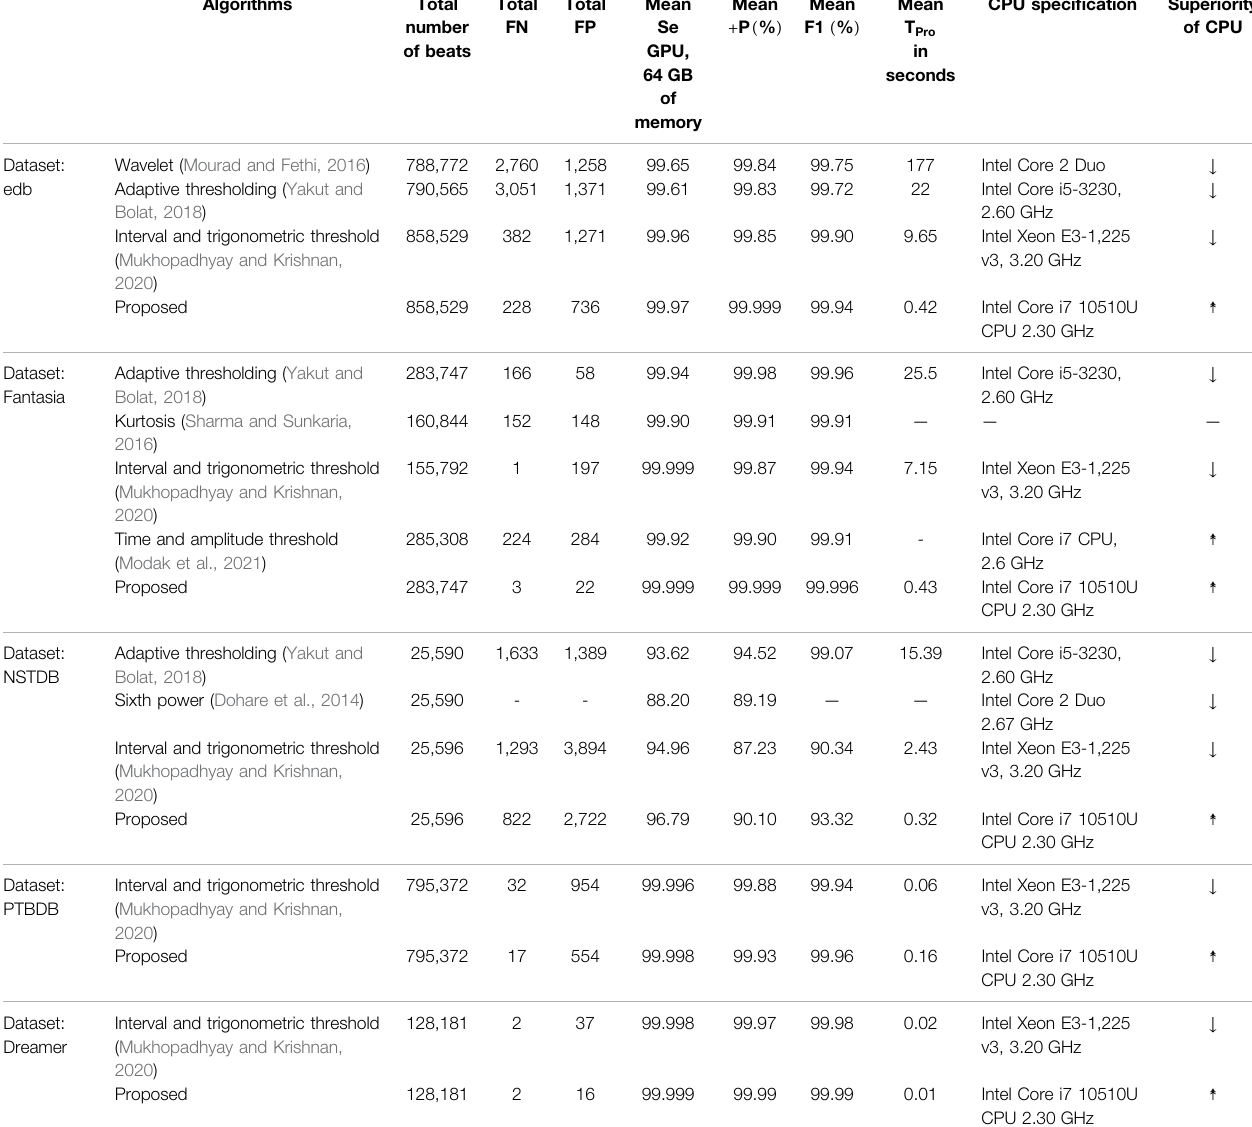
TABLE 7 | Performance comparison of the proposed algorithm with a few other recently developed algorithms on non-MITDB ECG databases.